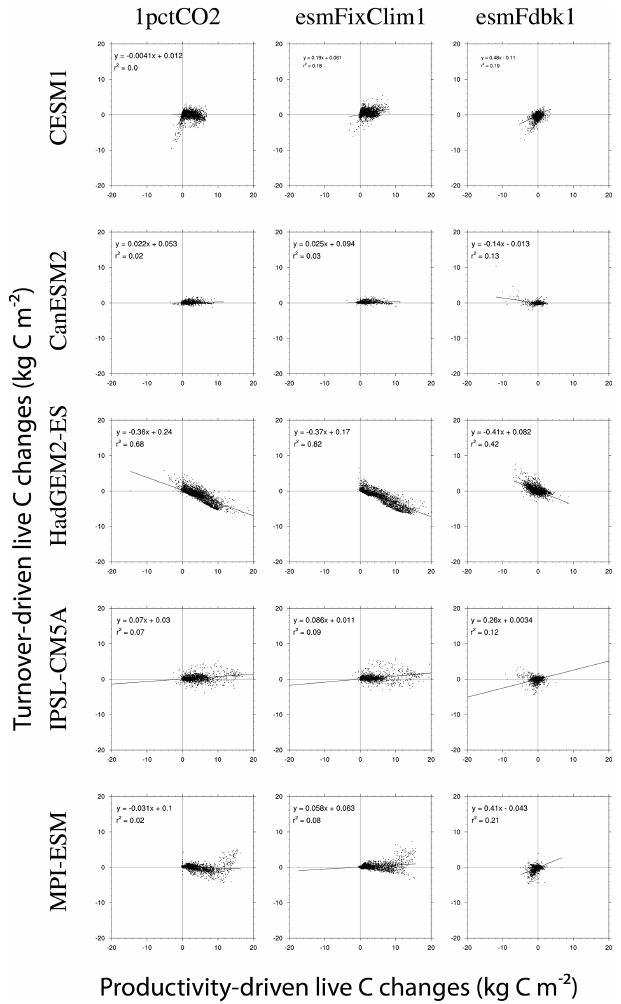
Figure 4. Scatterplots of productivity-driven vs. turnover-driven changes to the live pool equilibrium carbon amounts for each model and experiment.